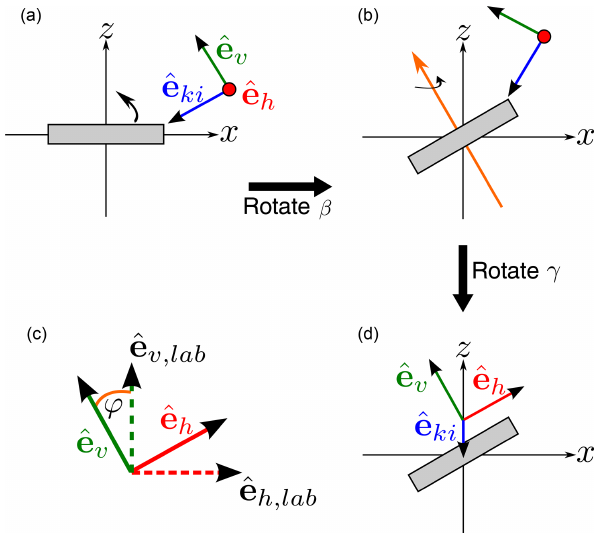
Figure B1. Change of the polarization directions under rotation. (a) The incidence direction unit vector ˆ e ki , together with the verti- cal polarization unit vector ˆ e v and the horizontal polarization unit vector ˆ e h , which are fixed to the particle, before the rotation is per- formed. (b) The unit vectors after the rotation by angle β and (d) af- ter the rotation by angle γ . As indicated in (c) , the polarization vec- tors after the rotation by angles β and γ are twisted by angle ϕ compared to the laboratory unit vectors.